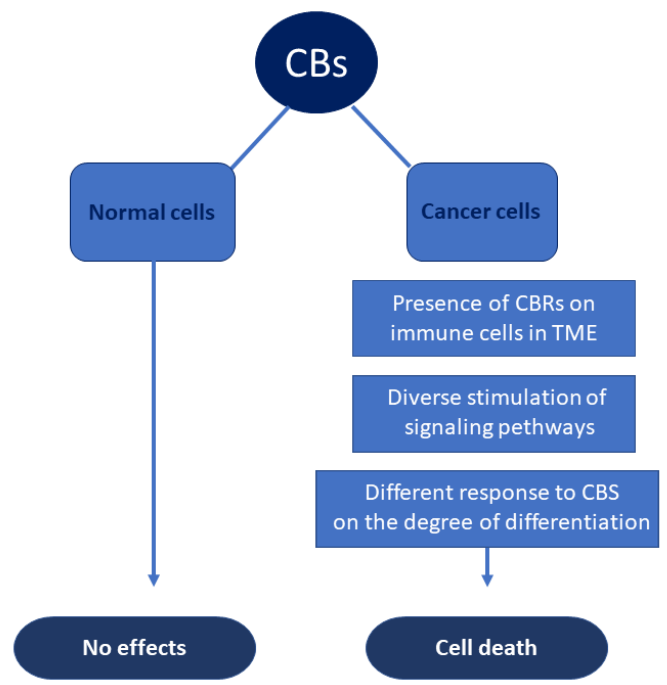
Figure 2. Differential effects of CBs on normal and neoplastic cells.